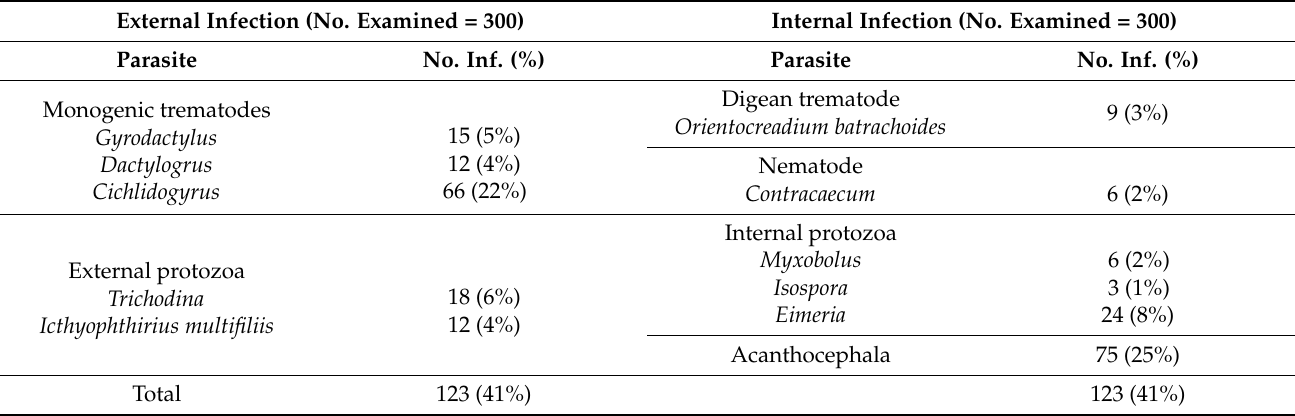
Table 2. Prevalence of ectoparasites and endoparasites in examined